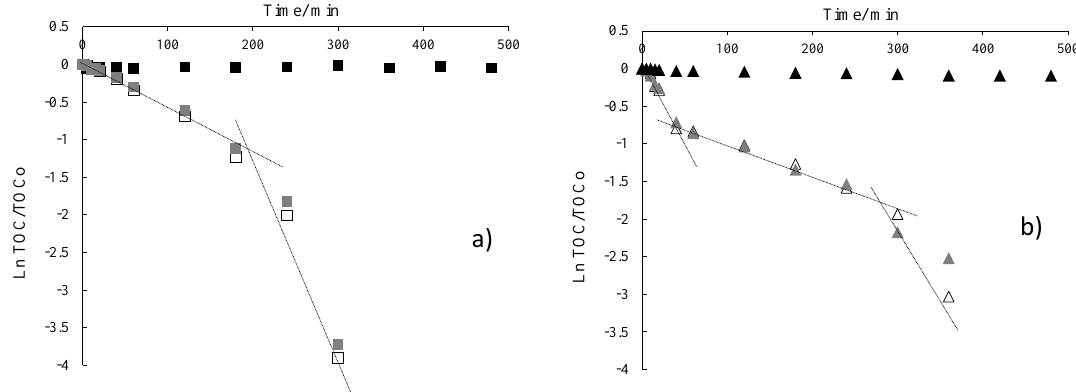
Figure 4. TOC removal in semi-log scale during the electrolysis (white symbols), photoelectrolysis (grey symbols) and photolysis (black symbols) of AMX and AMP solutions carried out in sulphate media ( a ) and chlorine media ( b ). Initial concentrations were 100 mg L − 1 of AMX and 100 mg L − 1 of AMP. Current density: 30 mA cm − 2 . UV light: 254 nm.